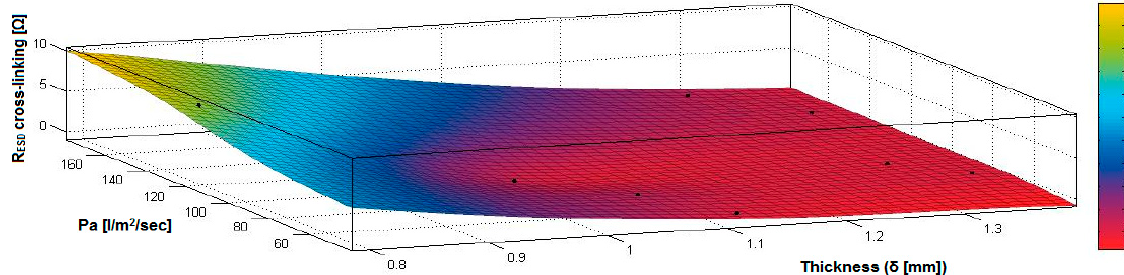
Figure 27. 3D representation R ESD after crosslinking = f(Pa, δ ) samples preliminarily treated in RF plasma O 2 using RF 1 generator and power 200 W.